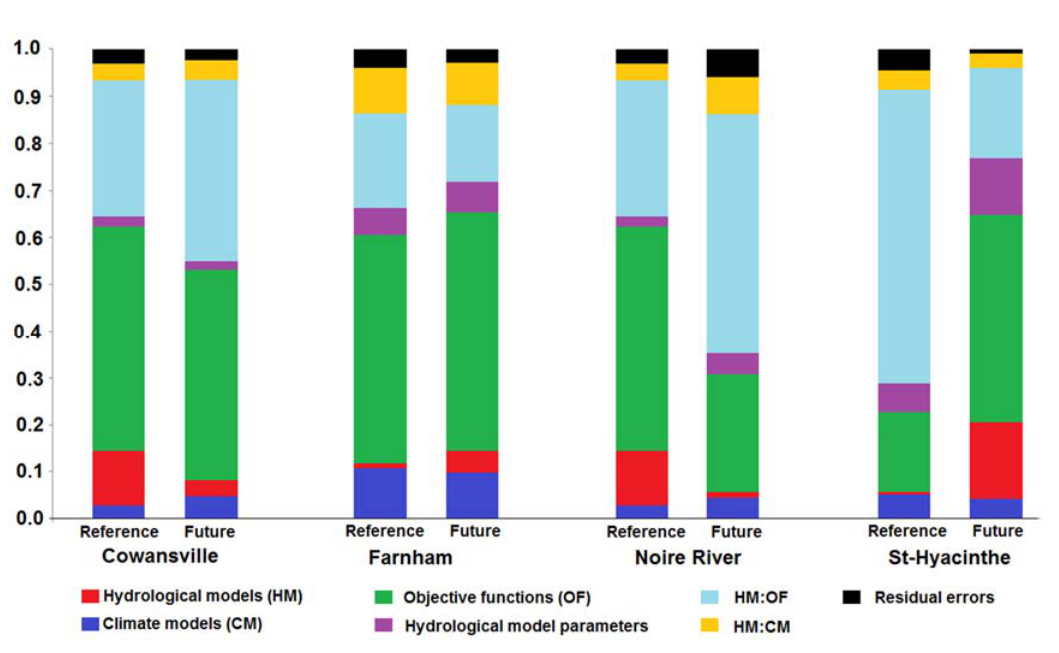
Figure 5. ANOVA partitioning among the sources of uncertainty computed on the 7Q2 index for each sub-watershed in reference and future periods.